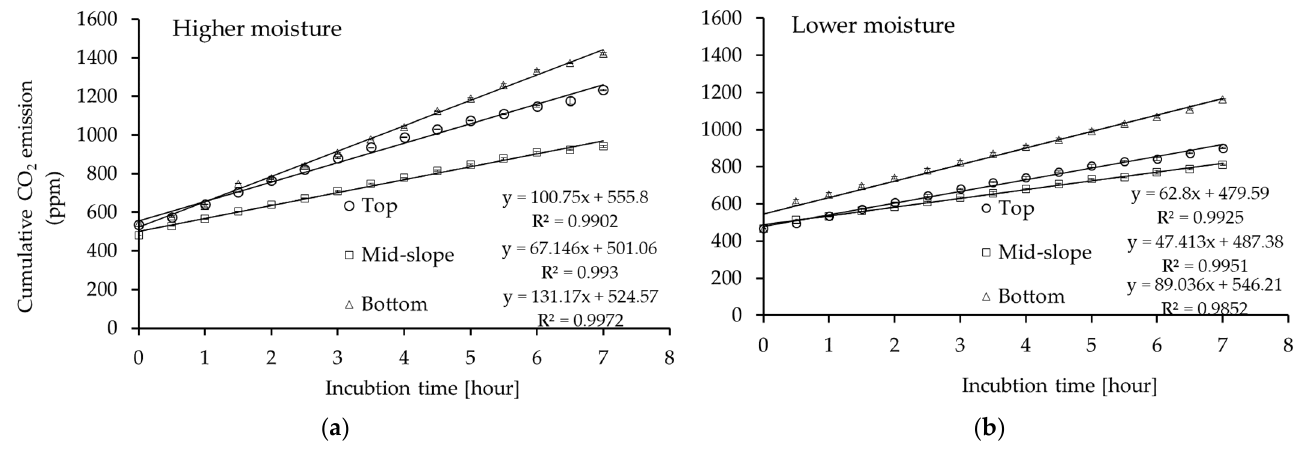
Figure 1. Cumulative CO 2 emission in soils from different positions of the forest gully: top, mid-slope, and bottom incubated at ( a ) higher moisture (12% vol.); ( b ) lower moisture (9% vol.) (average values ± 95% confidence intervals; n = 3).